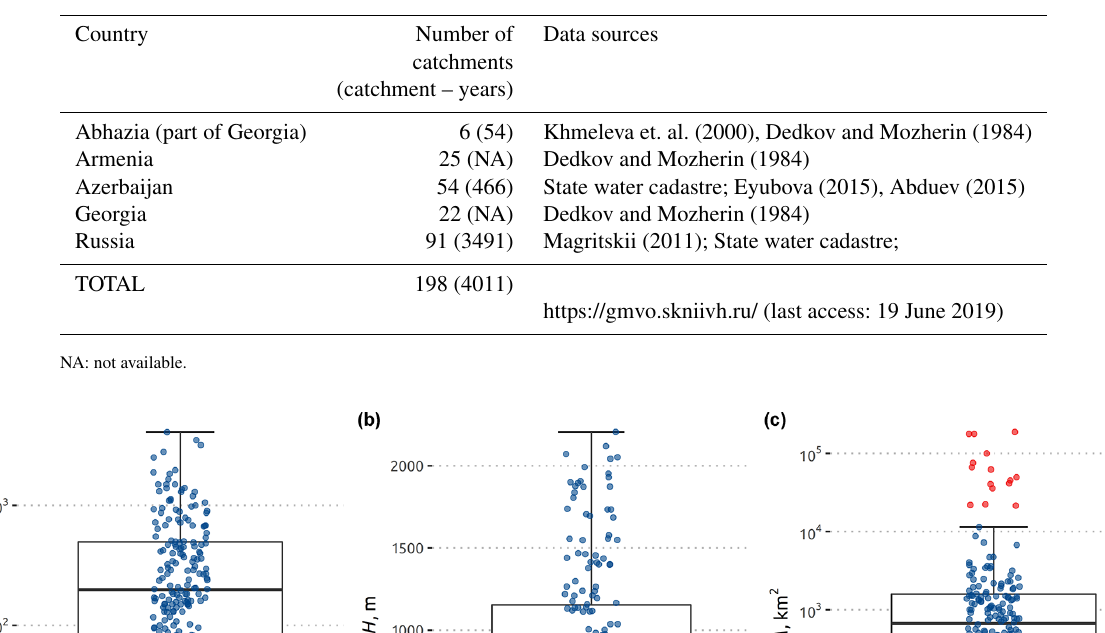
Table 1. SSY database overview (with outliers).